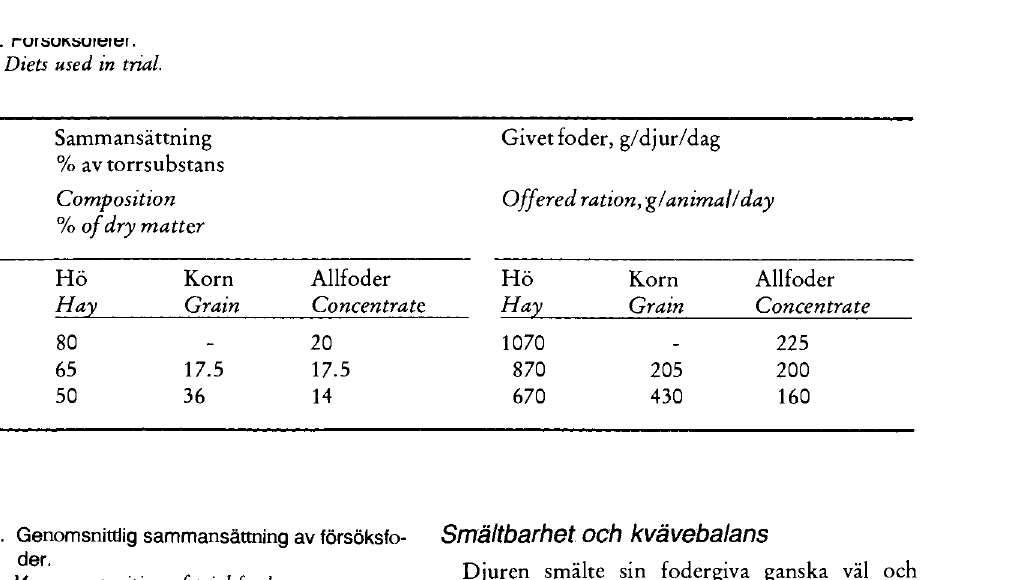
Table 2. Mean composition of trial